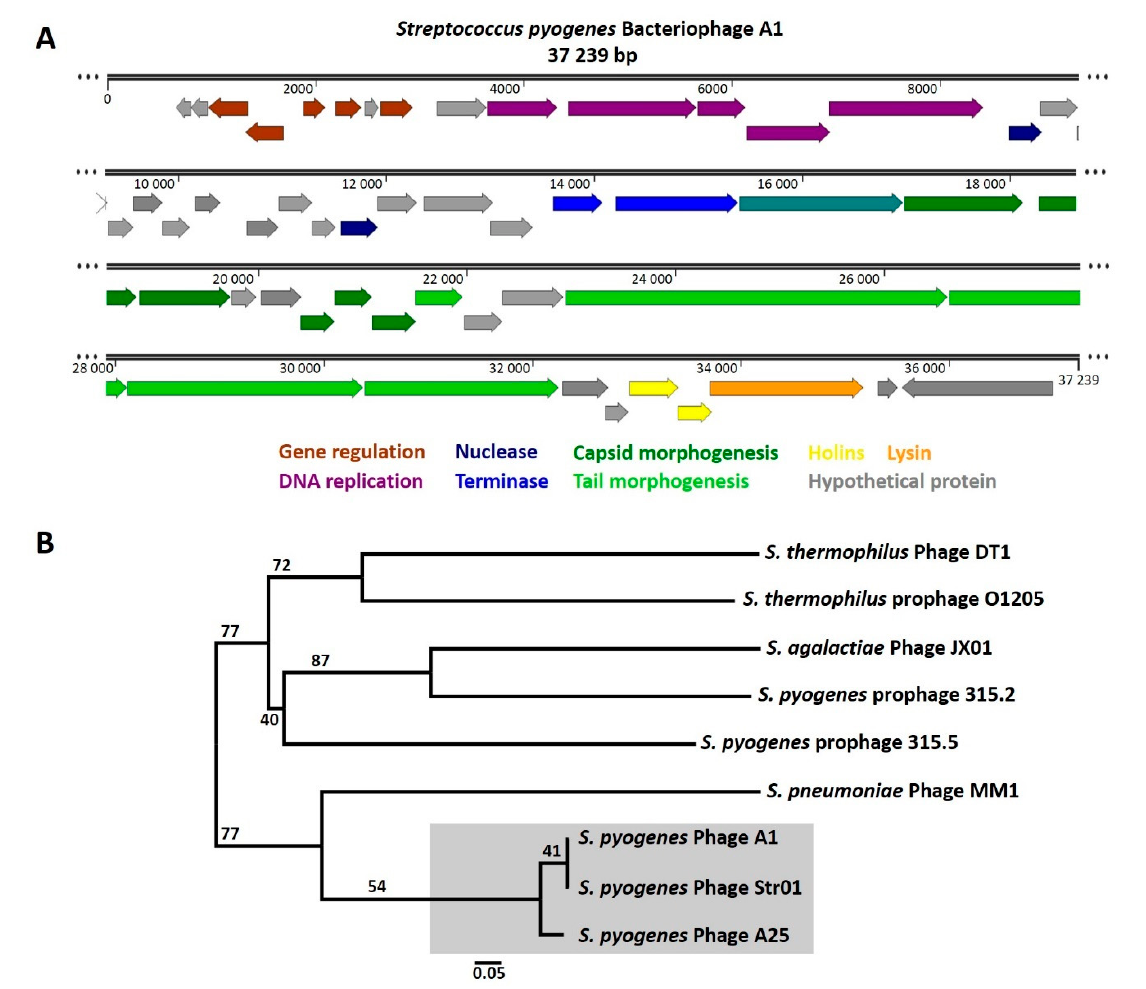
Figure 2. Genome sequence and phylogeny of S. pyogenes bacteriophage A1. ( A ) The Phage A1 genome is a 37,239 bp long circular dsDNA genome. Fifty-two gene products (Gps) were identiFigure 23. were encoding hypothetical proteins (gray). The genome follows the modular organization observed in other streptococcal phages, consisting of genes involved in regulation (brown), DNA replication (purple), nucleases (marine blue), DNA packaging (blue), portal protein (turquoise), capsid structure (dark green), tail morphogenesis (light green), holins (yellow) and a lysin (orange); ( B ) Whole genome-based phylogenetic tree of Phage A1 among streptococcal phages. The branch lengths are scaled in terms of the GBDP distance formula D 0 . Branch support was inferred from 100 pseudo-bootstrap replicates